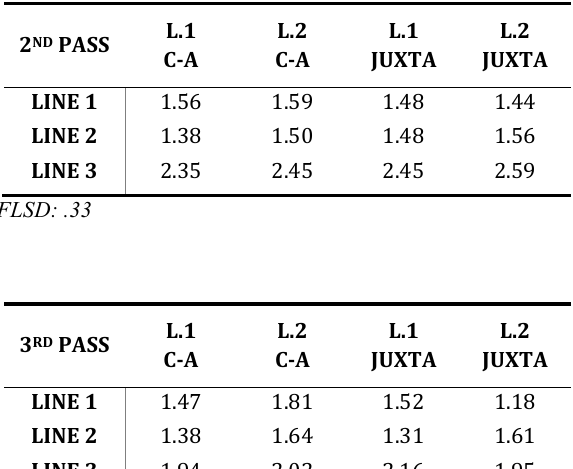
Supplementary Table S2. Average rank in which a given line was entered in second- and third-pass reading (upper and lower half of the table, respectively). FLSD: Fischer Least Square